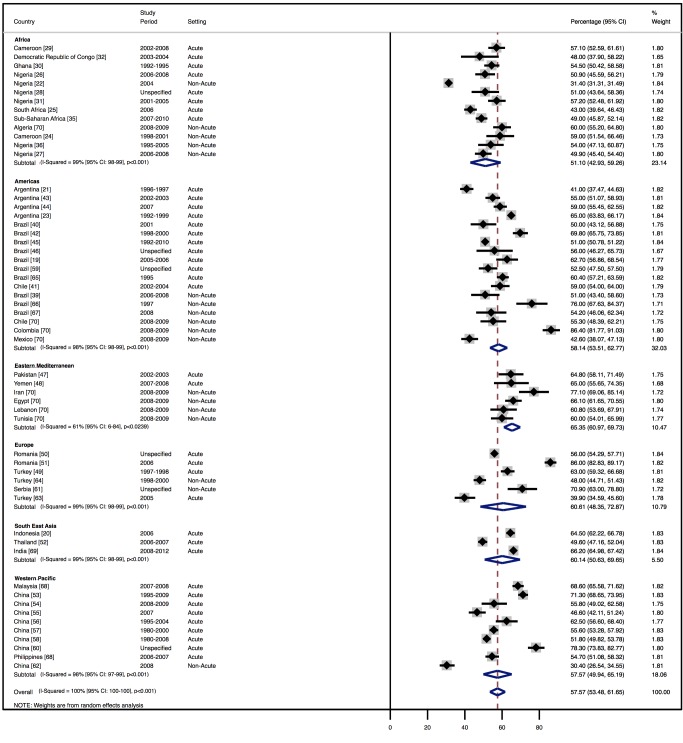
Male patients by region.